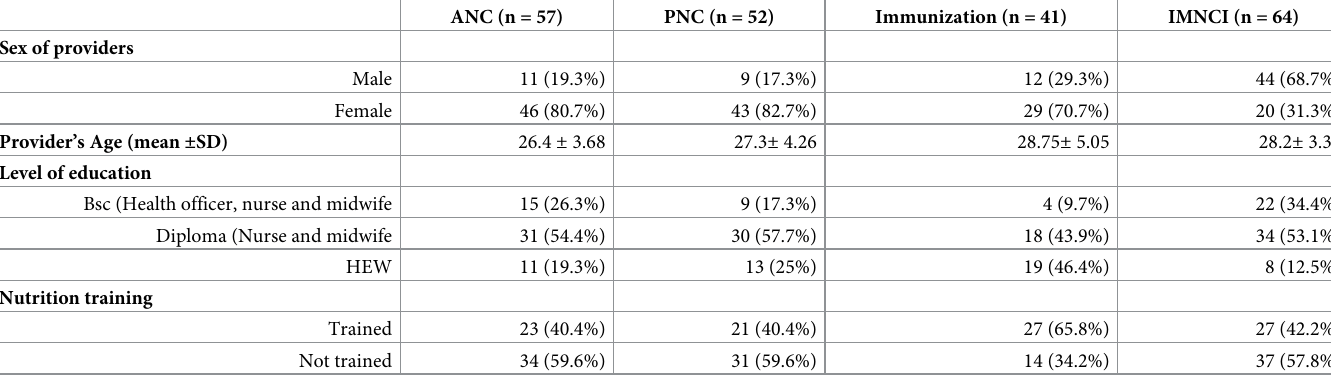
Table 4. Characteristics of health care providers delivering ANC, PNC, immunization and IMNCI at health centers and health posts.